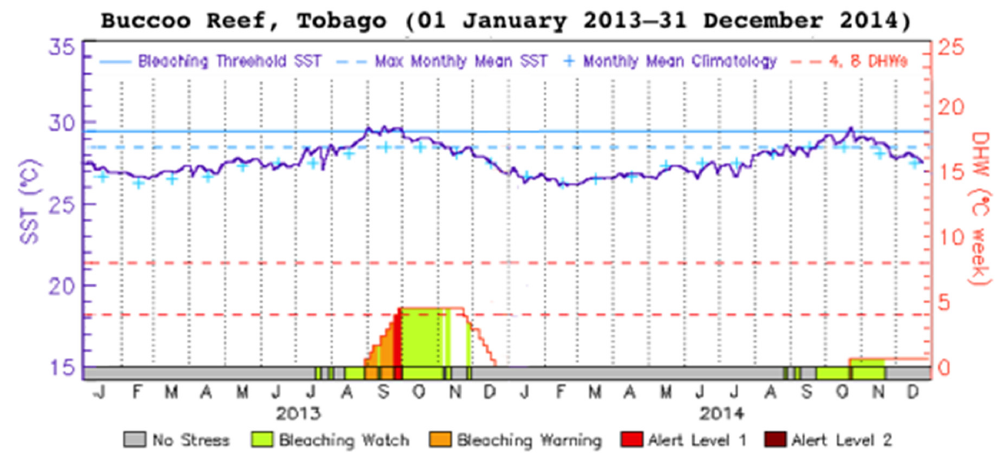
Figure 8. Twice-weekly 50 km sea surface temperature and Degree Heating Weeks (DHW) for 2013 and 2014. These products represent all three reefs sites: Buccoo Reef, Culloden and Speyside. In contrast, the 5 km DHW values that represent thermal stress at the three reef sites are from distinct pixels and therefore independent of each other (Figure 9). In 2013 the three maximum thermal